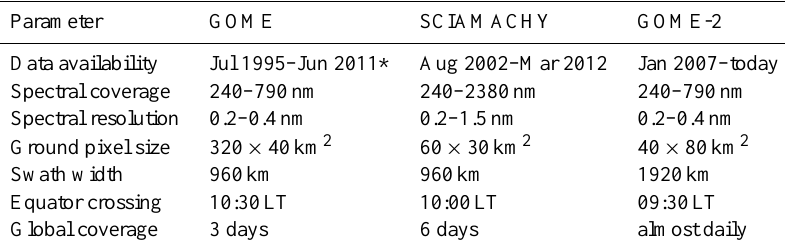
Table 2. Characteristics of the three European satellite instruments.